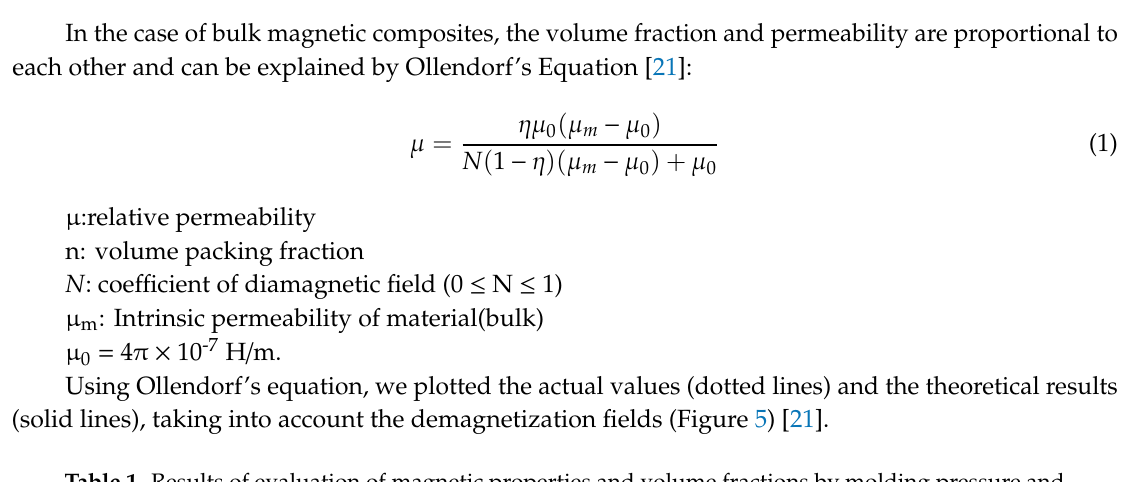
Table 1. Results of evaluation of magnetic properties and volume fractions by molding pressure and mixing ratio of magnetic bulk